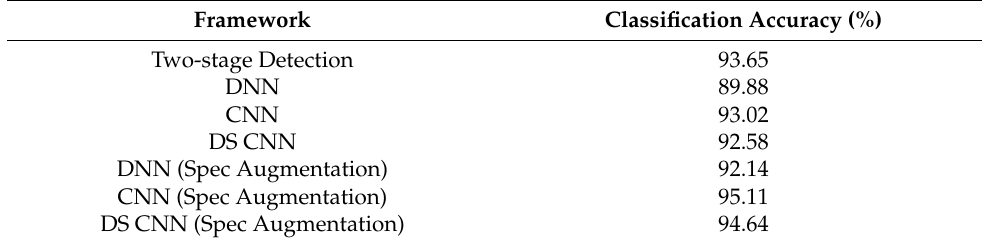
Figure 7. ( A ) The accuracy of the validation data vs. epoch; ( B ) the confusion matrix of the DS CNN. The frame-level classification results of the proposed models are given in Table 4. The accuracy of our baseline system, two-state detection is 93.65%. The classification accuracy results for the DNN, the CNN and the depthwise separable CNN models, are 89.88%, 93.02% and 92.58%, respectively. The accuracy results with data augmentation for the DNN, the CNN and the depthwise separable CNN models, are 92.14%, 95.11% and 94.64%, respectively. It can be seen that the classification accuracy is improved with augmentation. Table 4. The overall detection accuracy of each